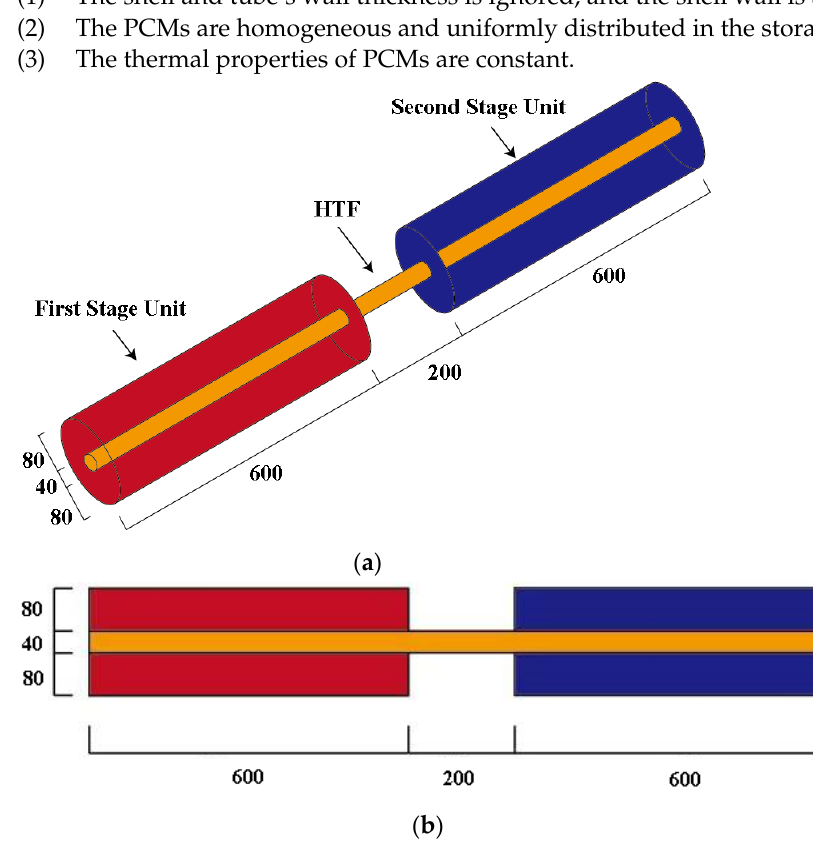
Figure 4. Physical model and 2D simplified model of the cascaded phase change heat storage: ( a ) Physical model; ( b ) 2D model.